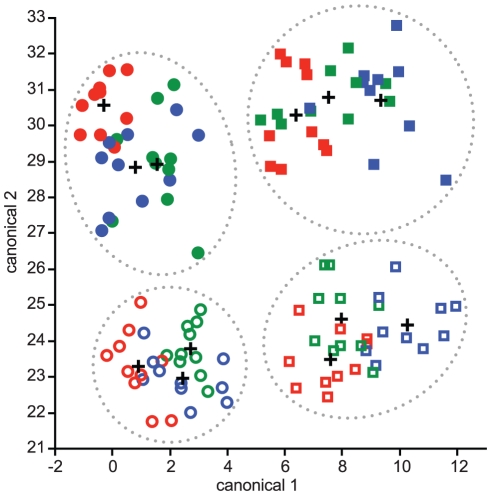

Pheidole subcastes and age groups have neural phenotypes that are well separated in multivariate space.Plot shows the separation of all 12 worker groups on the first two canonical variables generated by discriminant analysis (accounting for 87% of the total variance explained by the analysis). Four non-overlapping clusters (dotted ellipses) are generated by very strong discrimination among young minors, old minors, young majors, and old majors. Key: red, P. dentata; green, P. morrisi; blue, P. pilifera; open, young age cohort; closed, mature age cohort; circles, minor workers; squares, major workers; crosses, group centroids.